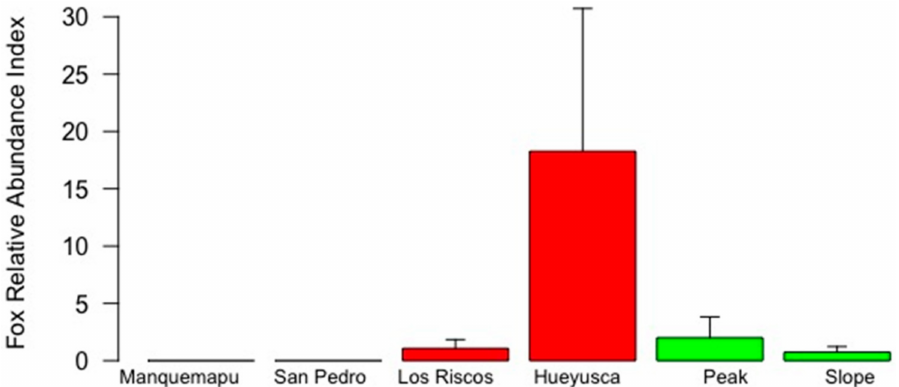
Figure 5. Fox RAI in six locations of the coastal range of southern Chile (whiskers represent 1 standard error). White, red and green bars identify coast, pre-mountain range and mountain range landscapes, characterized by intermediate, high and low degrees of human intervention, respectively. Table 4. Marginal likelihood ratio tests for secondary hypotheses, which considered the effects of